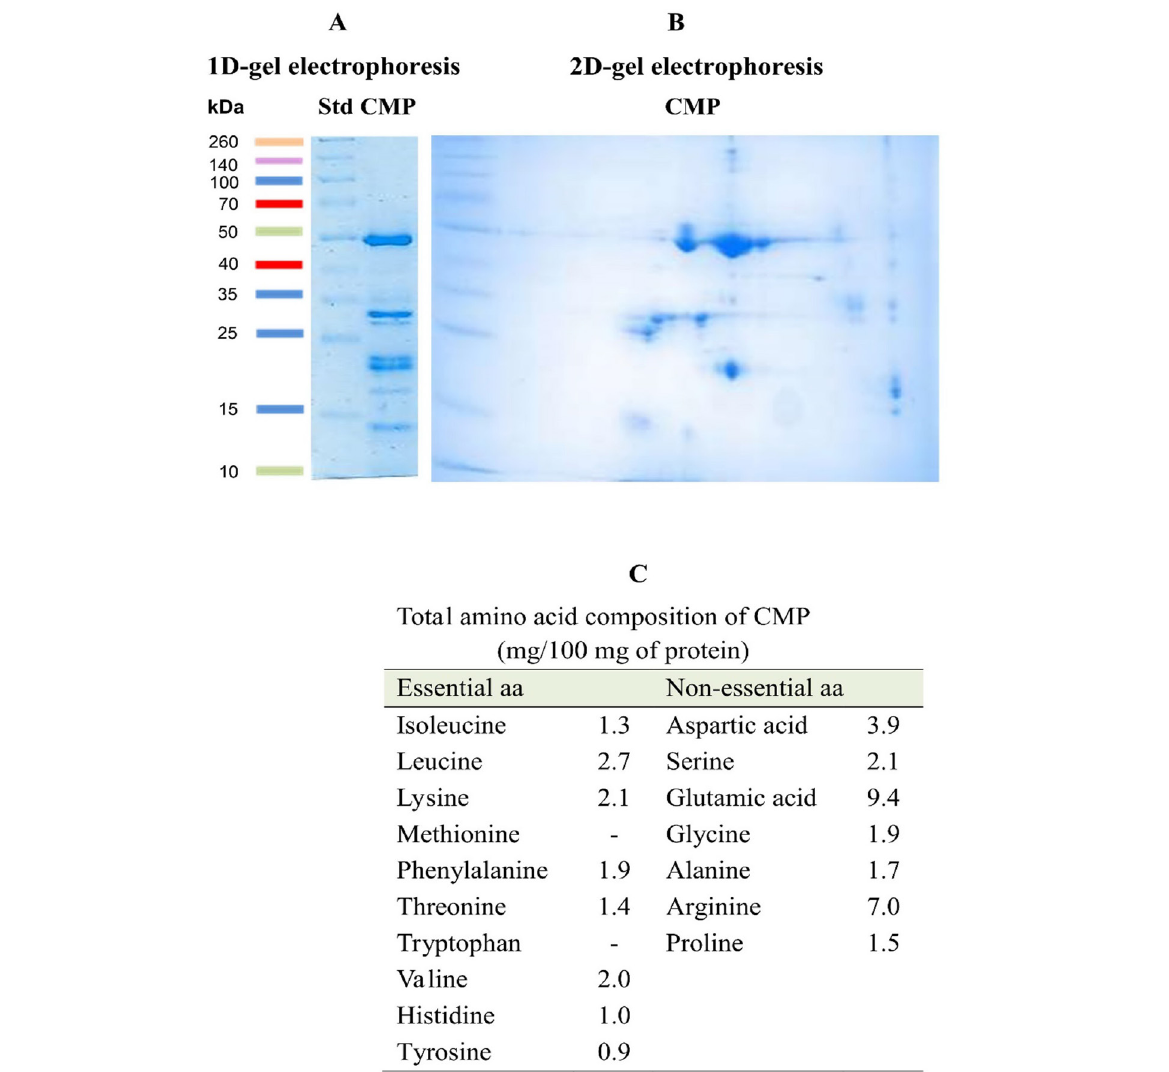
FIGURE 1 - Protein composition of coconut milk protein (CMP) analyzed by 1D (A) and 2D-gel electrophoresis (B) and its total amino acid (aa) composition (C) analyzed by in-house method (HPLC-precolum-AccQ.